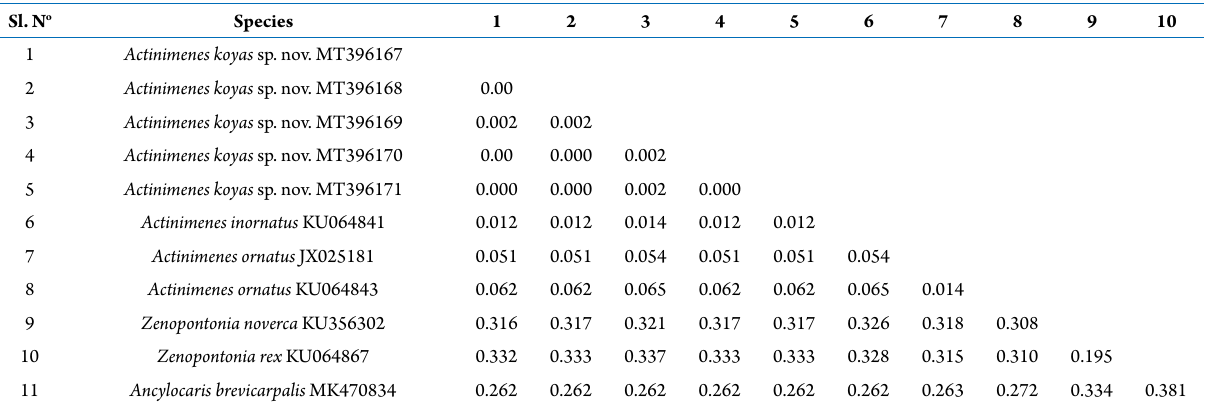
Table 4. Pairwise genetic distances calculated using Kimura 2-parameter model with 16S sequences of genus Actinimenes, Ancylocaris and Zenopontonia. Sl. N